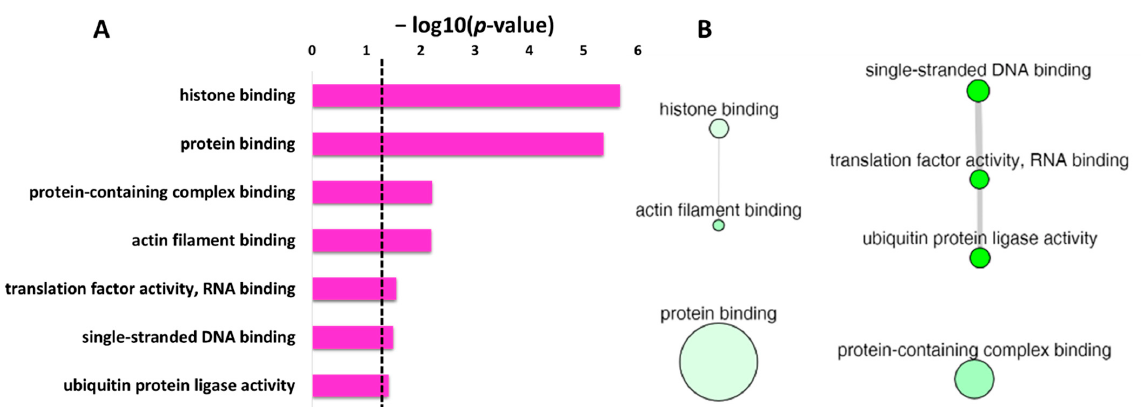
Figure 6. REVIGO analysis for the non-redundant enrichment items in molecular function for the protein targets of penetratin. ( A ) list of non-redundant enrichment items in molecular function category with corresponding p -value (the dotted line represents p -value = 0.05). ( B ) The graph-based visualization shows clusters between similar non-redundant items in molecular function. Non-redundant terms are represented by bubbles, the color of bubble from light to dark green illustrates the p -value from lowest to highest, the size of the bubbles indicates the frequency of each GO term, and the width of the line connecting the bubbles represent the degree of similarity.